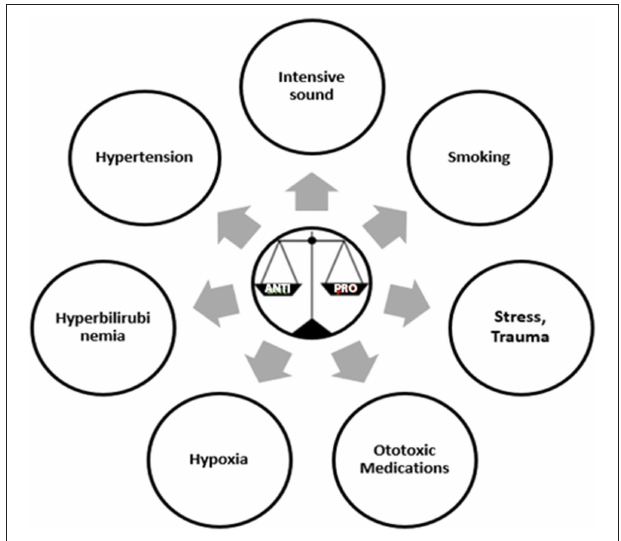
FIGURE 1 | Sterile inflammatory factors that can induce a risk for Non-Syndromic Hearing